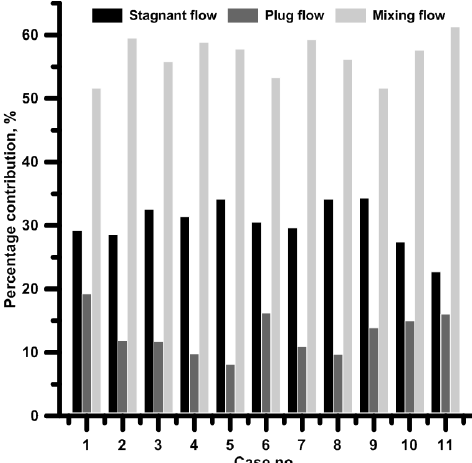
Figure 3. Hydrodynamic conditions for considered tundish variants with steady position of ladle shroud.